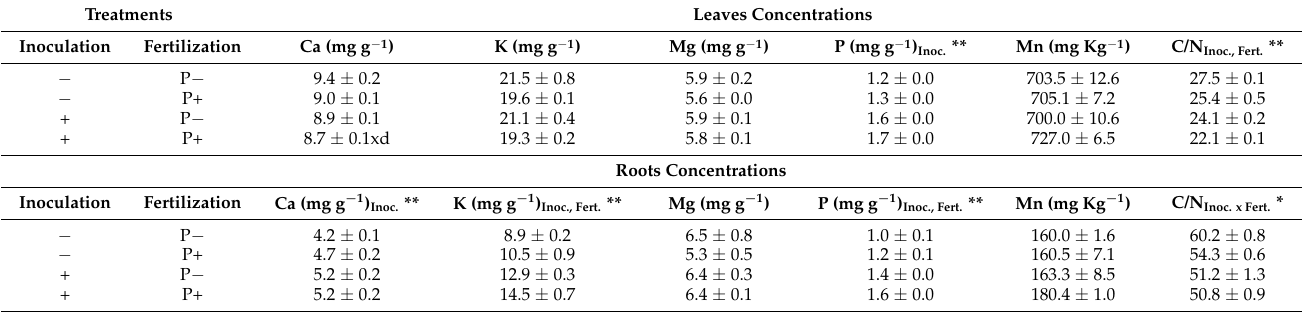
Table 2. Leaves and root ion concentrations and C/N ratio in inoculated (+) and non-inoculated ( − ) strawberry plants with a designed bacterial consortium and fertilized with BNM medium without phosphorus (P − ) or with BNM medium supplemented with an insoluble phosphorus form Ca 3 (PO 4 ) 2, (P+), after 120 days. Values represent mean ± SE of 10 replicates. Leaves